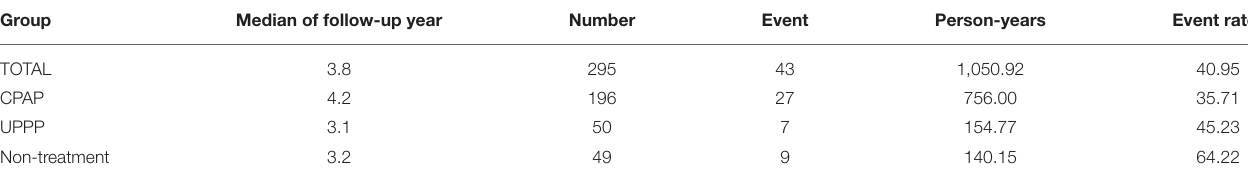
TABLE 2 | Event rate of hypertension across the three groups.